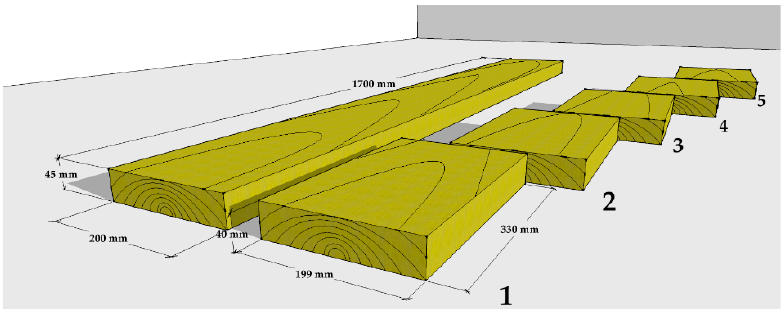
Figure 1. Scheme of preparation of test specimens from the tangential board.